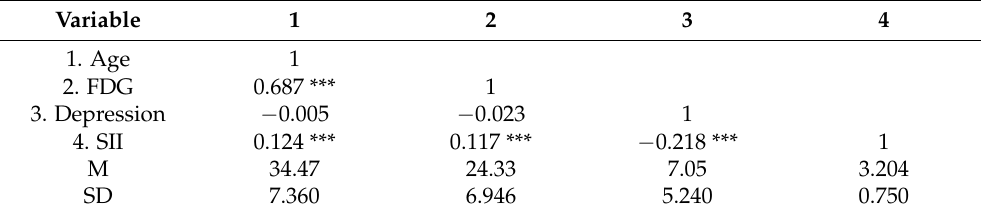
Table 1. Results of descriptive statistics and correlation analysis of depression and impulse inhibition.